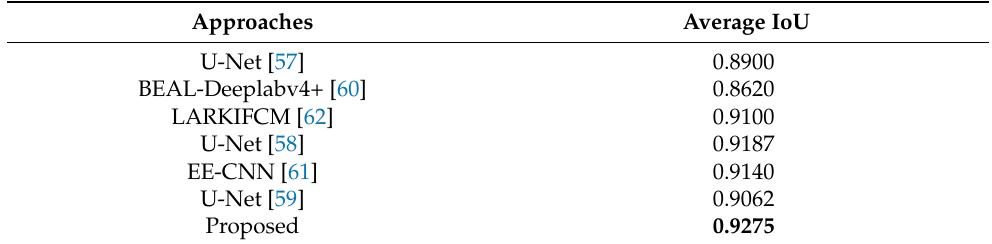
Table 6. Comparison of results in the DRISHTI-GS dataset with those in other papers with average IoU.